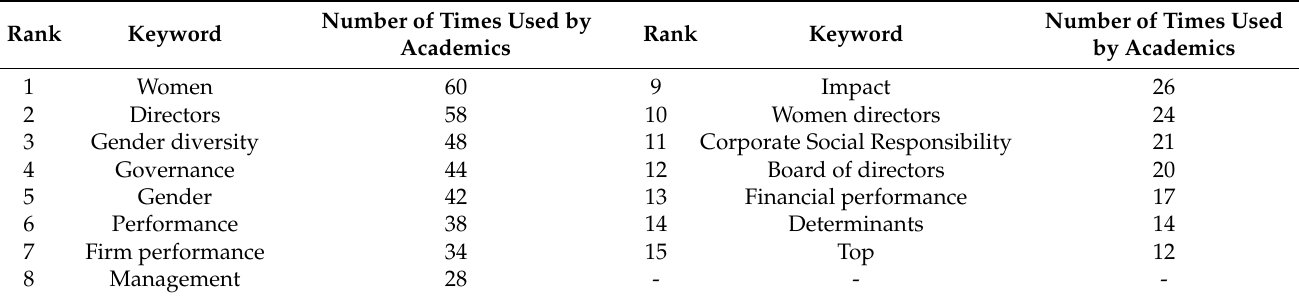
Figure 4. VOSviewer network visualization of the bibliometric keywords map. Table 2. Ranking of the most cited keywords by the